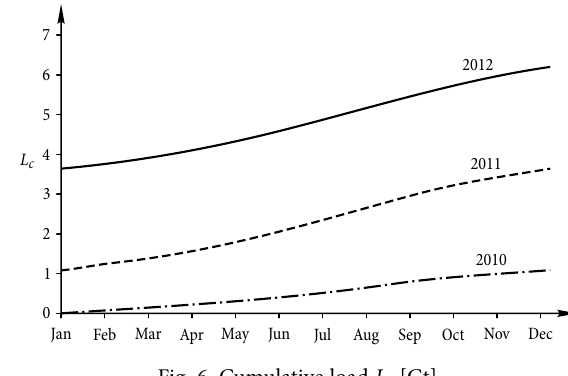
Fig. 6. Cumulative load L c